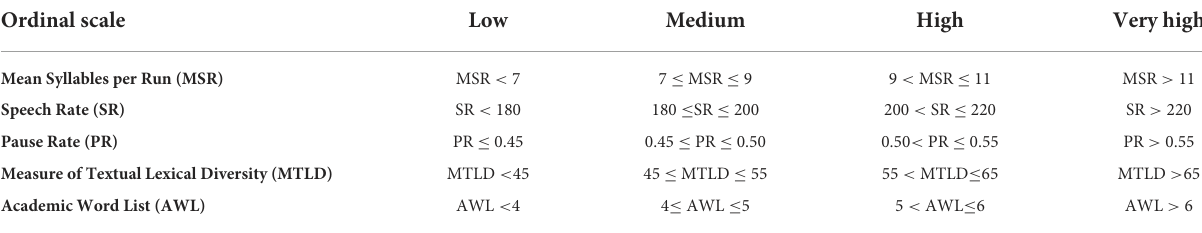
TABLE 7 Ordinal scale conversion of fluency and vocabulary features.